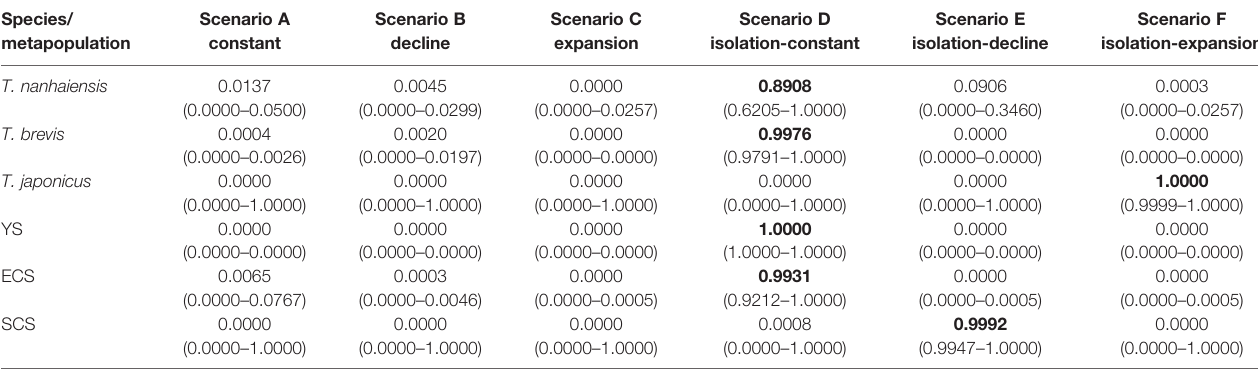
TABLE 4 | Relative posterior probabilities for each scenario and their 95% con fi dence intervals in parentheses the based on the logistic estimate by DIYABC. Species/ metapopulation